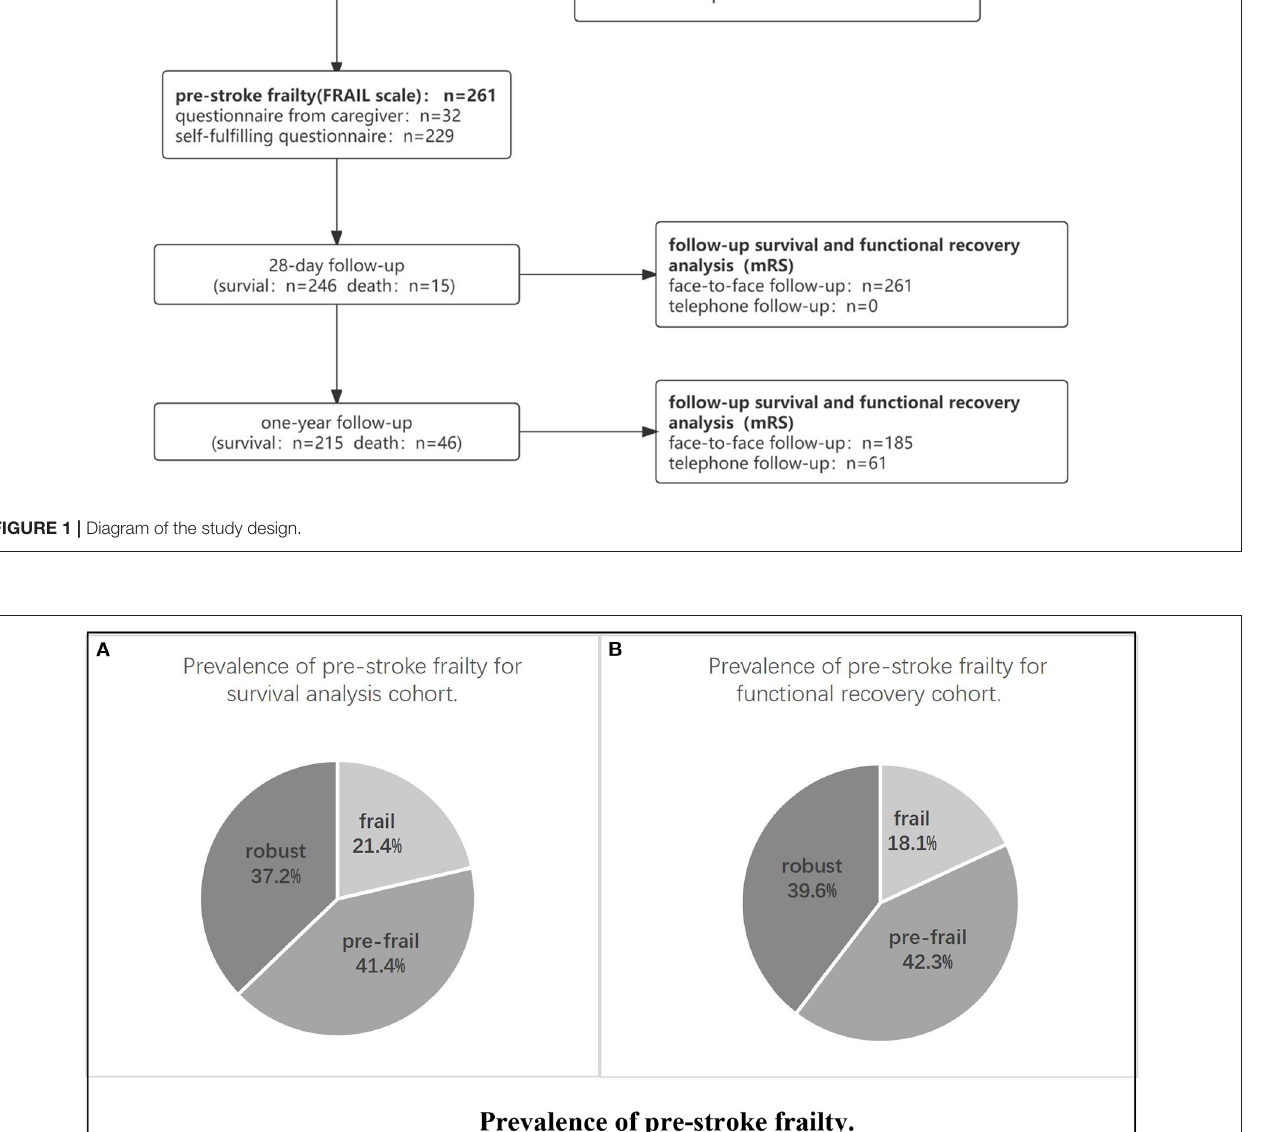
Frontiers in Neurology |